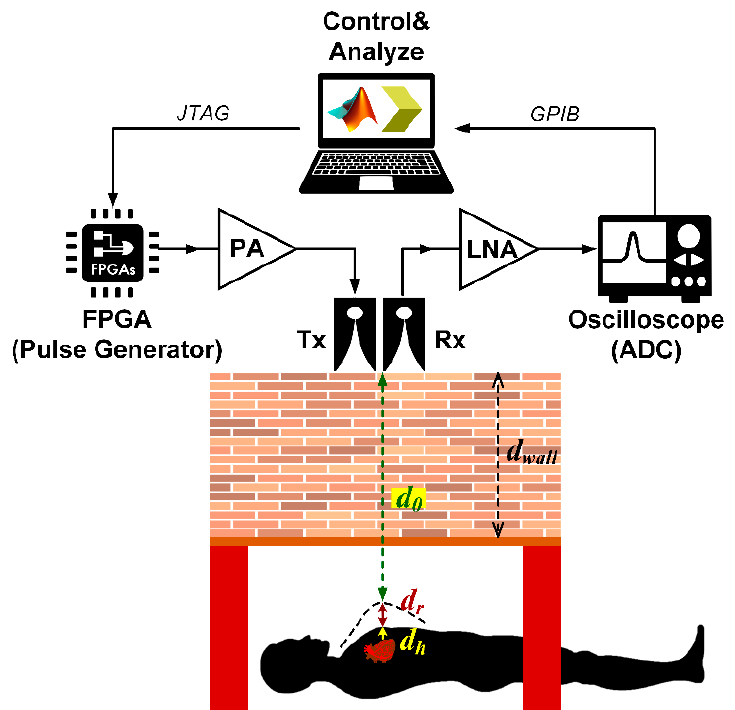
Figure 12. Schematic of IR-UWB pulse generation using FPGA scheme for detection of human subject underneath layers of stacked clay bricks.